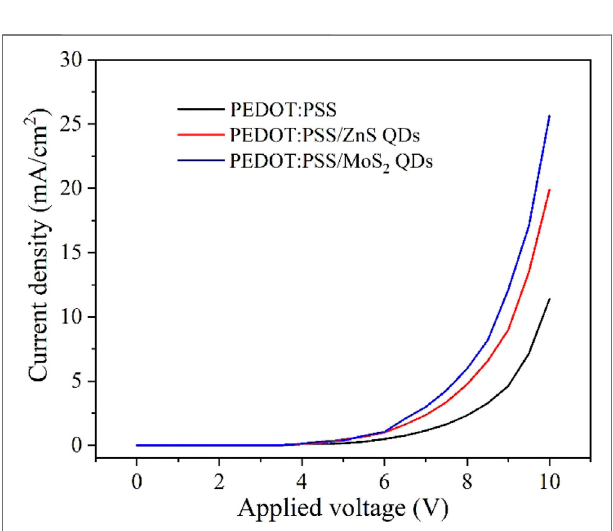
FIGURE 8 | The J-V characteristics of hole-only devices of ITO/HIL (40 nm)/NPB (100 nm)/Al (100 nm).